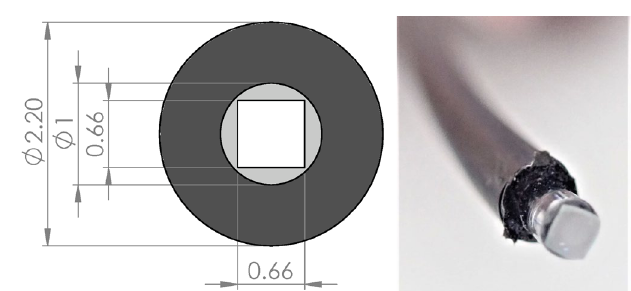
Fig. 8. Horizontal section in scale (a) and picture (b) of the SH4001 optical fiber with a squared 0.66 × 0.66 × 0.225 mm ND2:1 screen glued at the